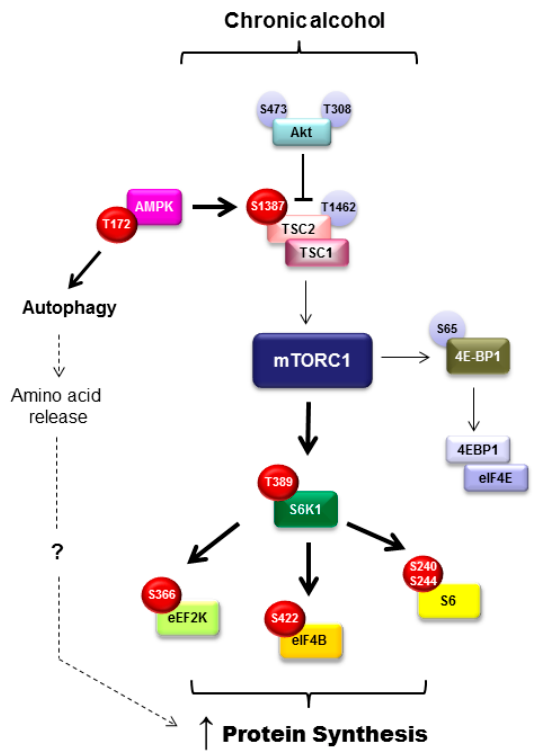
Figure 2. Effect of chronic alcohol intake on mammalian/mechanistic target of rapamycin complex 1 (mTORC1) signaling in white adipose tissue from mice. Bold arrows indicate activation of selected pathway components; red circles indicate an alcohol ‐ induced increased in phosphorylation and the presumed activation of respective substrates; light blue circle indicates phosphorylation site not altered by alcohol; hashed lines indicated a hypothesized mechanism. Abbreviations: threonine (T) of given phosphorylation site; serine (S) of indicated phosphorylation site; tuberous sclerosis complex 1/2 (TSC); eukaryotic initiation factor 4E (eIF4E) binding protein 1 (4E ‐ BP1); ribosomal protein S6 kinase (S6K1); ribosomal protein S6 (S6); elongation factor 2 kinase (eEF2K); and eukaryotic initiation factor 4B (eIF4B).